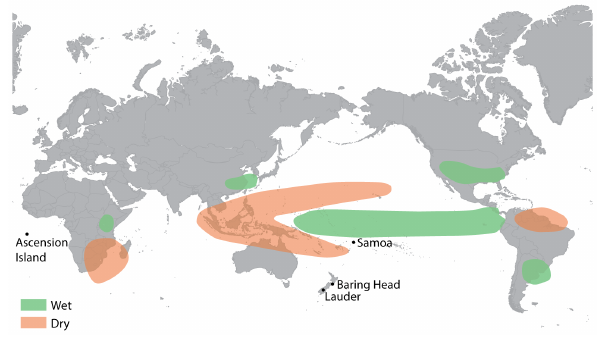
Figure 1. Regions of ENSO impacts and monitoring stations used in this study. The map indicates the locations of the atmospheric mon- itoring stations on Ascension Island (ASC), Samoa (SMO), Baring Head (BHD), and Lauder (LAU). General precipitation anomalies during Northern Hemisphere El Niño conditions for December– February are taken from https://www.climate.gov/news-features/ featured-images/global-impacts-el-nino-and-la-nina (last access: 5 December 2017). El Niño dry regions in June–August are similar for southern Asia and South America; during La Niña events op- posite patterns for wet- and dryness develop in roughly the same